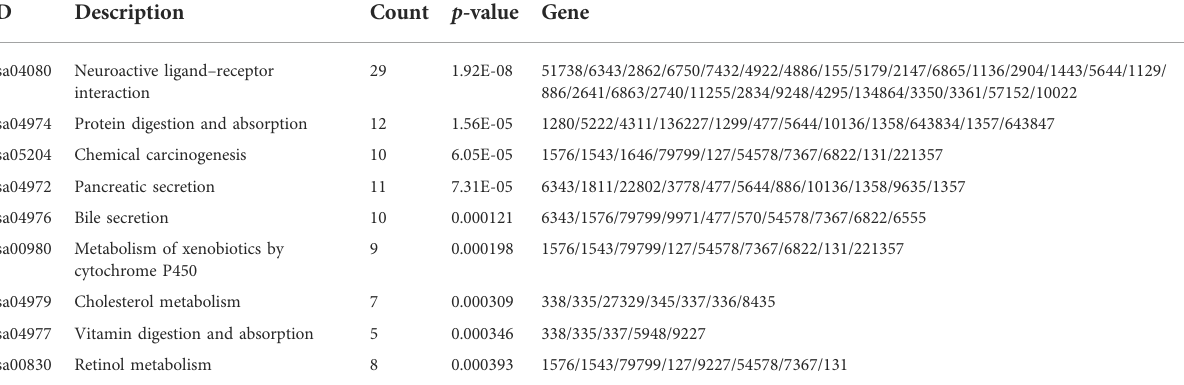
TABLE 5 Kyoto Encyclopedia of Genes and Genomes pathway enrichment analysis using differentially expressed